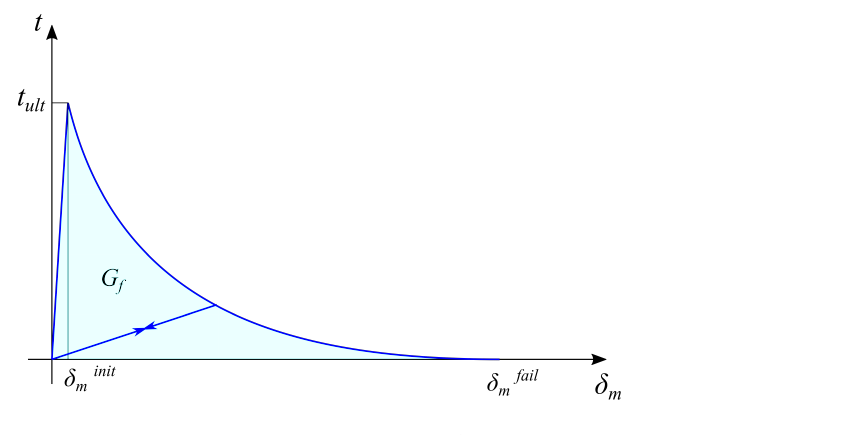
(cid:113) (cid:104) t n (cid:105) 2 + t 2 + t 2 s t